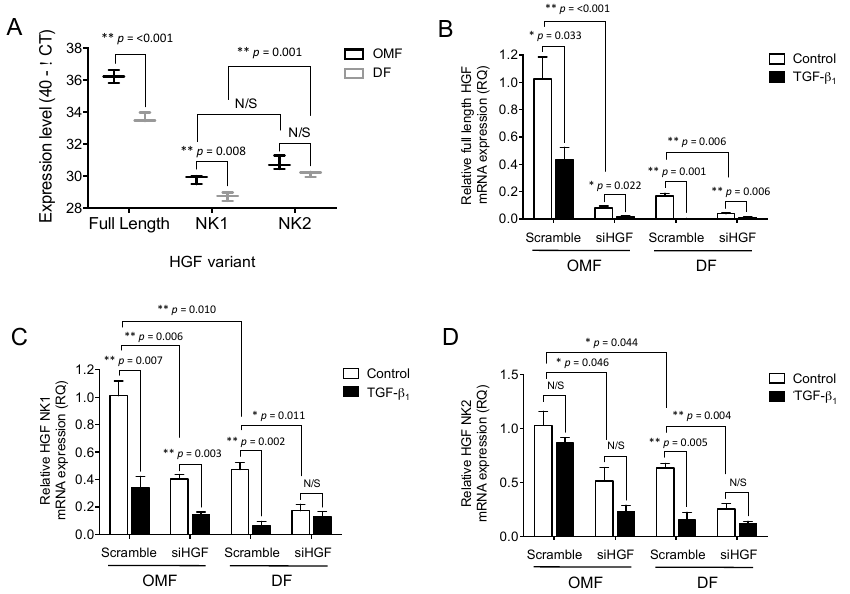
Figure 5. HGF isoforms are differentially expressed in OMFs vs. DFs, and following supplementation with TGF- β 1 . OMFs and DFs were transiently transfected with either siHGF or scrambled siRNA. siHGF- and scrambled siRNA-transfected cells were growth-arrested and maintained in serum-free F-SCM (open bars), or serum-free F-SCM containing TGF- β 1 (10 ng/mL, solid bars), for 72 h. ( A ) Differences in basal levels of full-length HGF and truncated NK1/NK2 isoform mRNA expression in OMF (black lines) and DF (grey lines) were analysed by RT-qPCR, and are displayed as 40- ∆ CT. The expression of ( B ) full-length HGF, ( C ) truncated NK1, and ( D ) truncated NK2 mRNA, was assessed by RT-qPCR. Data is shown as mean ± S.E. for n = 3 independent experiments (* p ≤ 0.05, ** p ≤ 0.01; N/S, no significance).